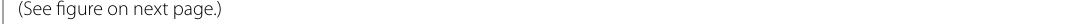
100 μm. B‑C . mPFC showed a significant increase of c-Fos + cell density ( B ) and = 5/group. D . Representative pictures of c-Fos (red) and NeuN = 100 μm. E–F. In the ACC, no significant differences in c-Fos + cell density ( E ) and = 5/group. One-way ANOVA with the Tukey post hoc tests, * P < 0.05, ** P < 0.01. =